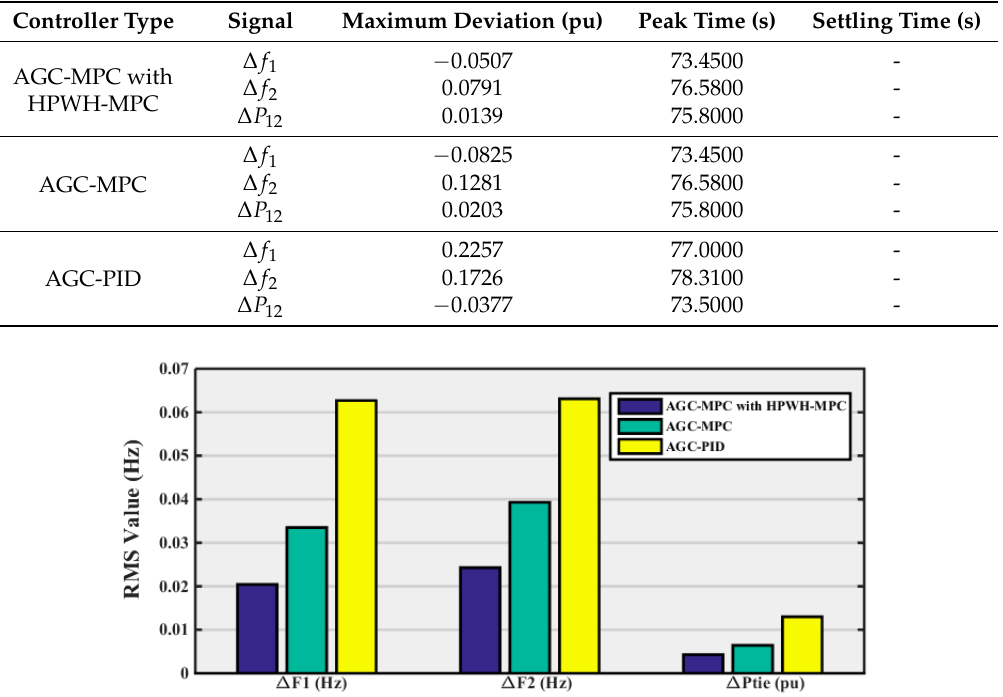
Table 3. Peak overshoot, peak time and settling time for the controllers in the second scenario.